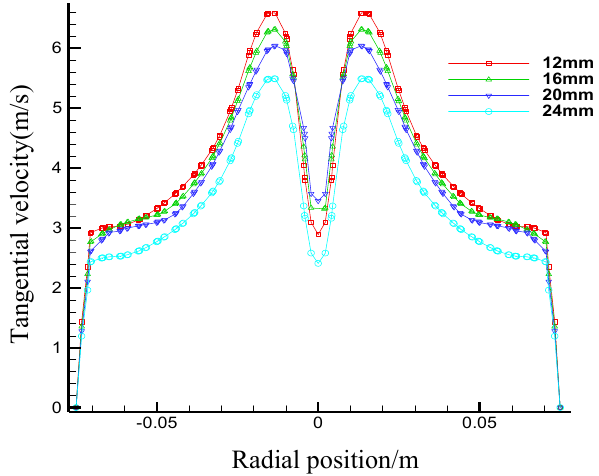
Figure 18. Tangential velocity inside cyclone with different I underflow pipe.